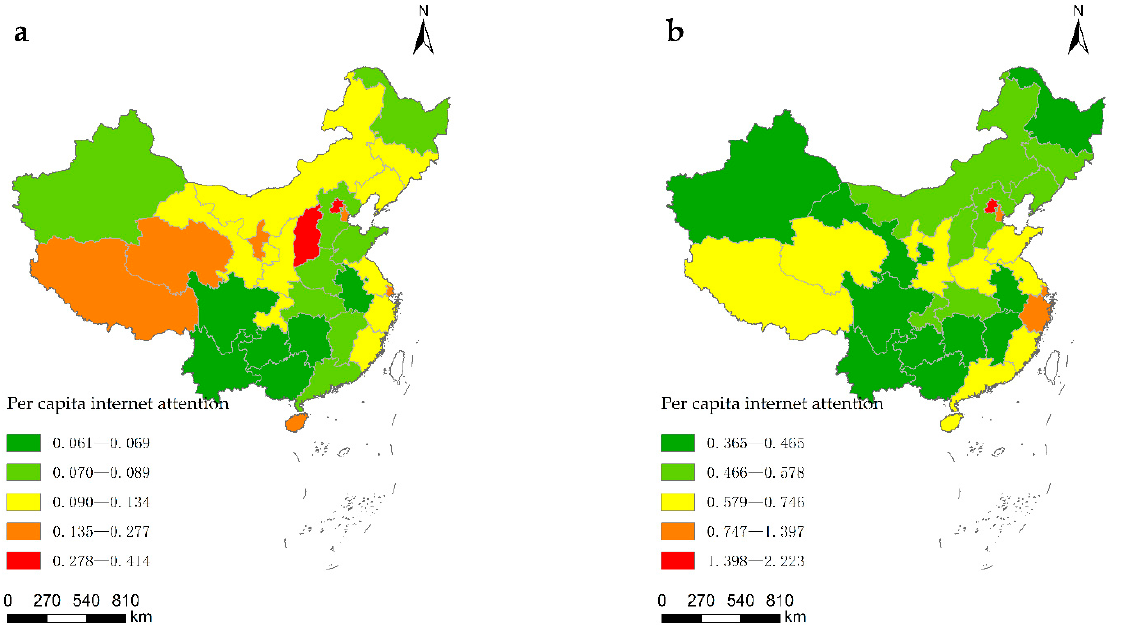
Figure 5. Provincial geographical distribution of per capita internet attention to torrential rain. (Note: ( a ) the per capita internet attention of Shanxi Province; ( b ) the per capita internet attention of Henan Province). (The map is based on the standard map of the Technical Review Centre for Maps of the Ministry of Natural Resources (review number: GS (2019) 1822), with no modifications to the base map).